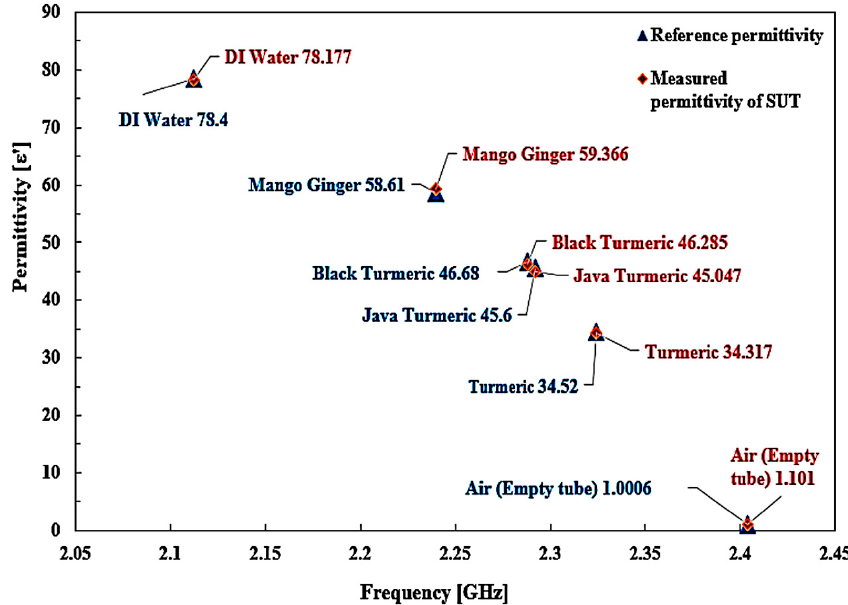
Figure 18. Comparison of the ideal and measured real part permittivity of several semi-solid SUTs. The permittivity values measured are tabulated in Table 7. Every single substance has itself. In other terms, the permittivity may be derived from the frequency-shifting response.